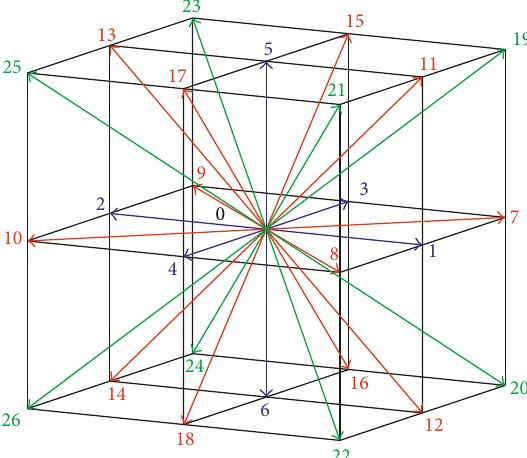
Figure 1: Three-dimensional twenty-seven particle velocity (D3Q27)